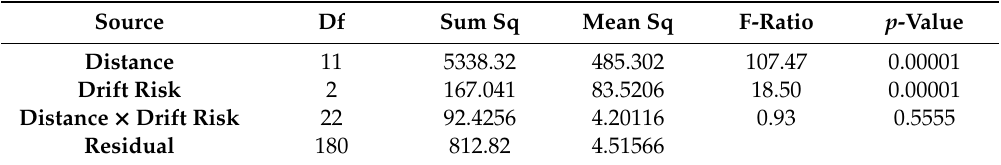
Table 4. Results of ANOVA for sedimenting spray drift as a ff ected by distance and drift risk indication (Df: degrees of